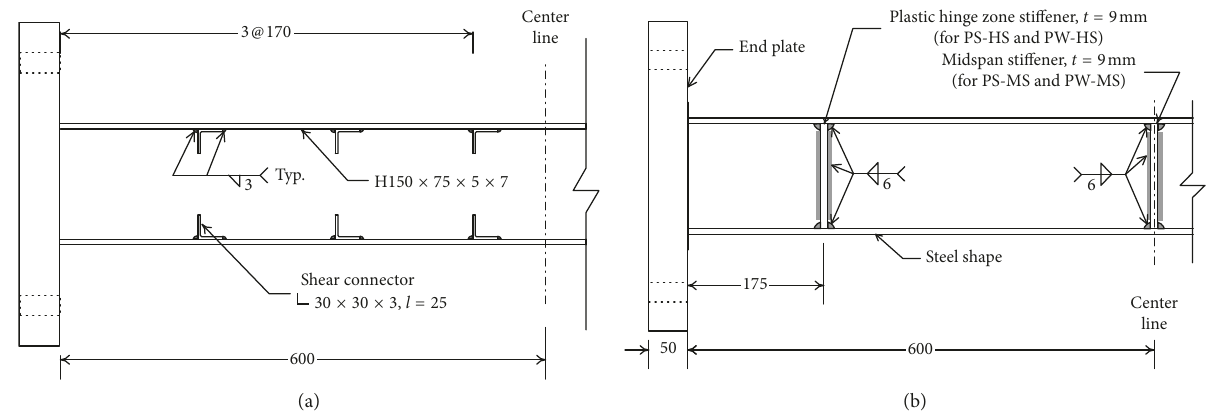
Figure 8: Concrete constraint scheme. (a) Elevation view specimens with shear connectors (PS-SC and PW-SC). (b) Elevation view (PS-NB, PS-HS, PS-MS, PW-NB, PW-HS, and PW-MS).